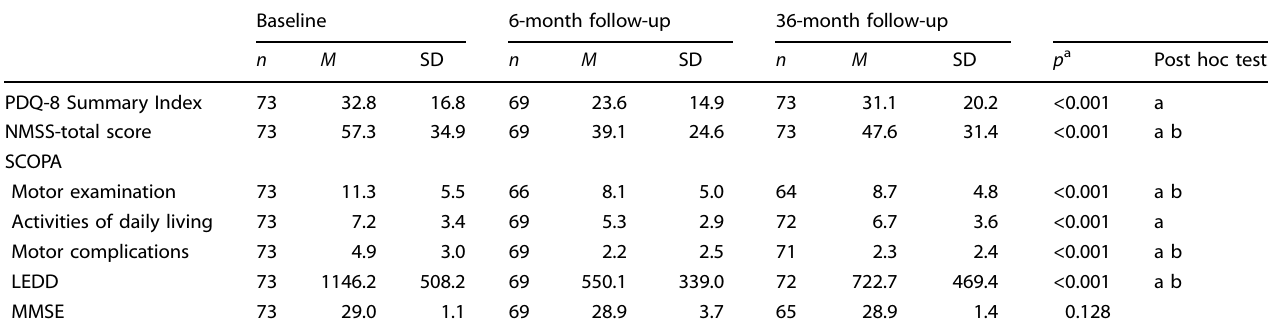
Table 1. Outcome parameters at preoperative baseline and postoperative 6-month and 36-month